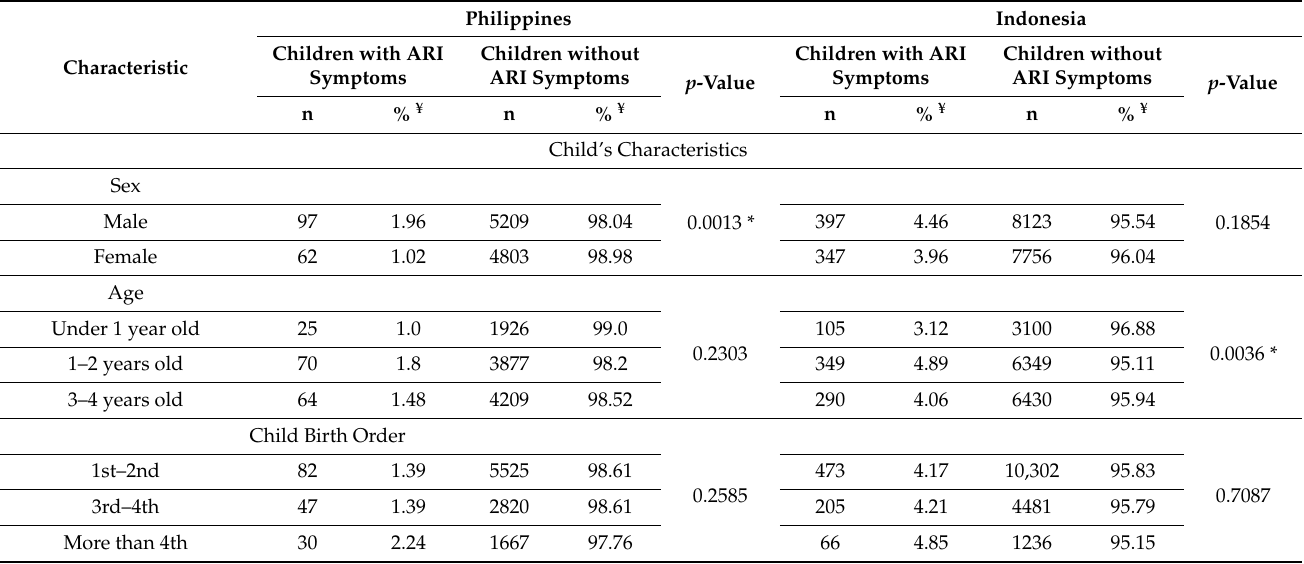
Table 2. Relationship between the characteristics of children, mothers, and households in the Philippines and Indonesia in